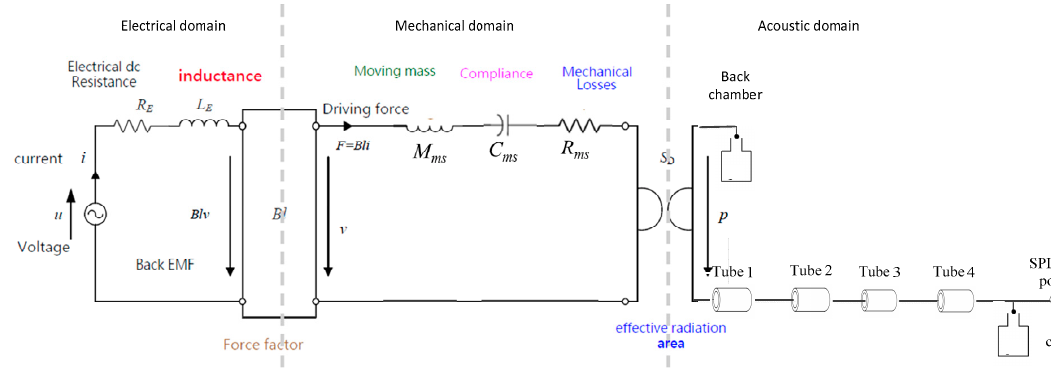
Figure 8 . Equivalent circuit of BAR.